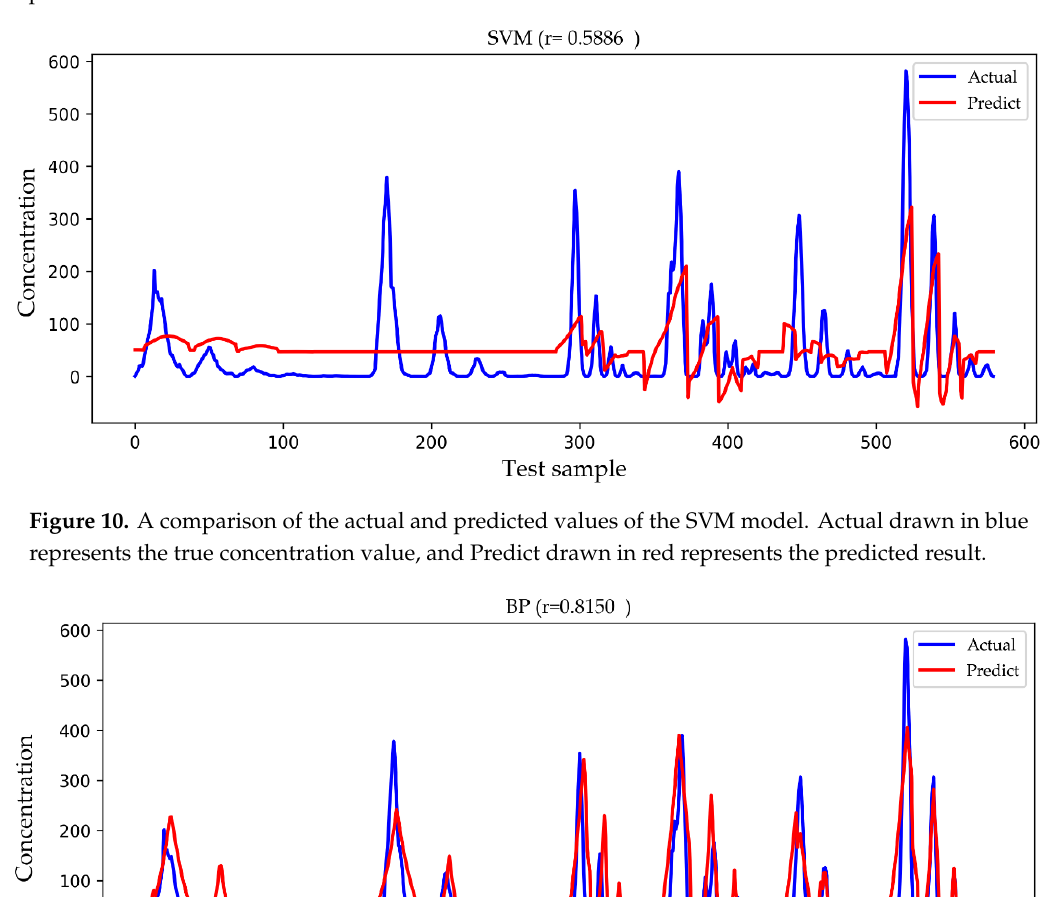
Figure 9. A comparison of the actual and predicted values of the Gaussian diffusion model. Actual drawn in blue represents the true concentration value, and Predict drawn in red represents the predicted result.